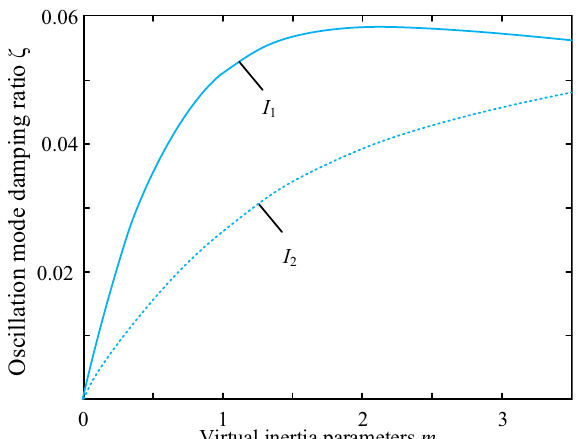
Figure 7. Comparison of sensitivity of oscillation mode damping ratio to damping